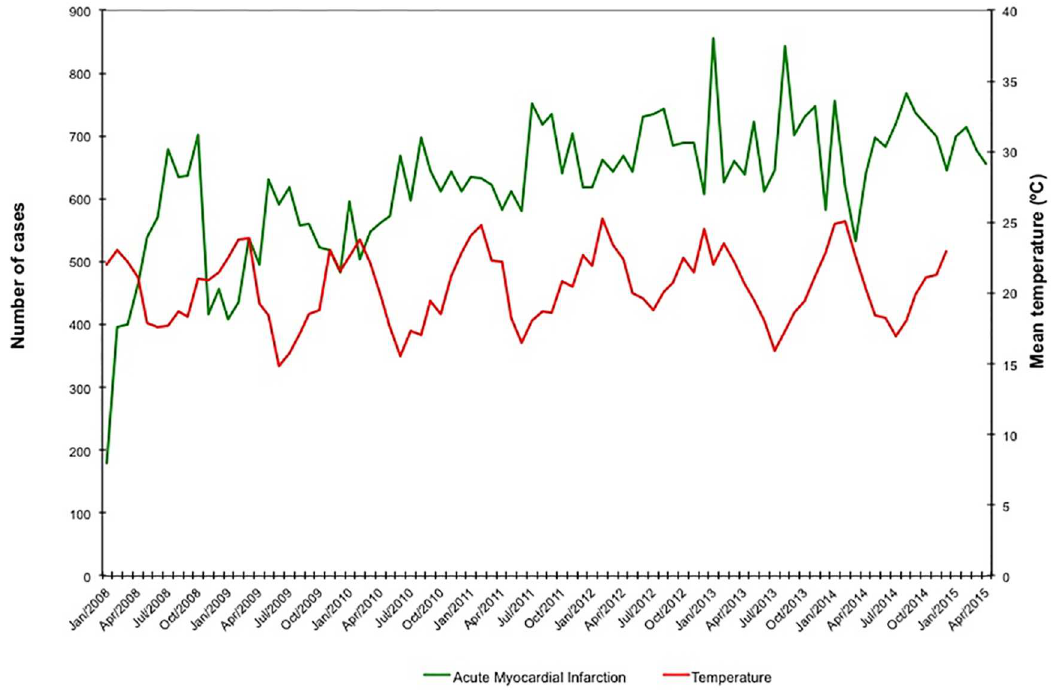
Fig 2. Monthly average temperature levels and number of hospitalizations per month for acute myocardial infarction.